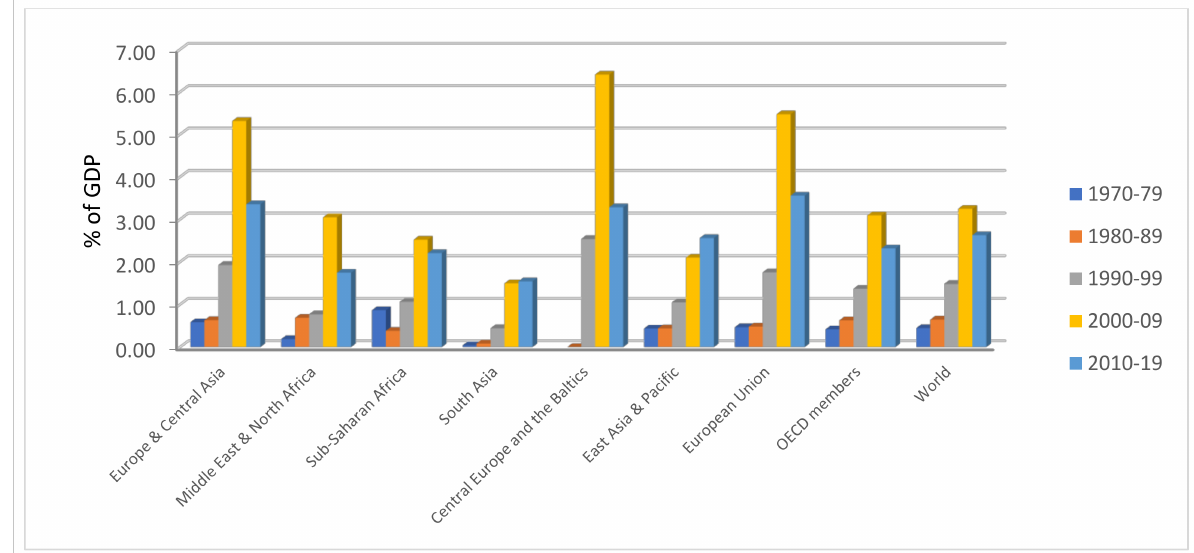
Figure 2. Trend of FDI to GDP across the world regions. Source: World Bank Development Indicator Database